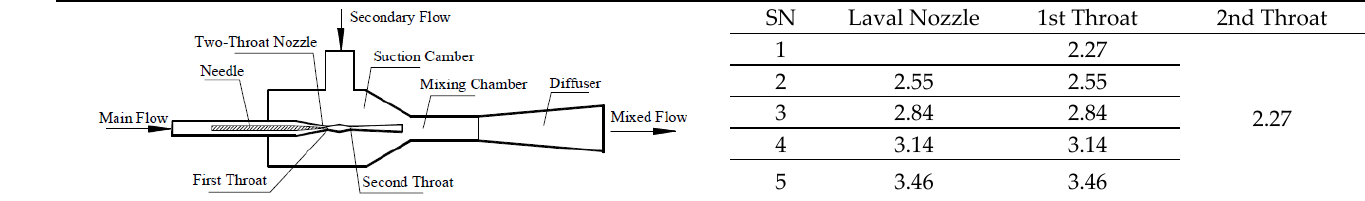
better performance of ejectors.